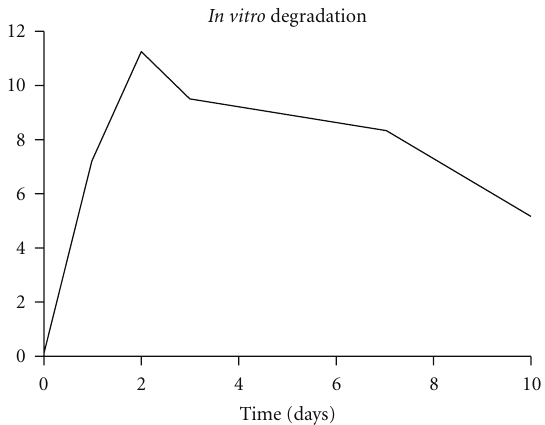
Figure 2: For in vitro release tests aprotinin was used. aprotinin is a protein with approximately same size as IGF-I. The aprotinin concentration was measured over the time. After an initial peak, a constant release over at least 10 day took place.